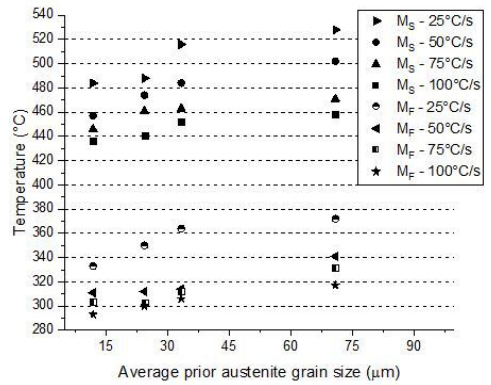
Figure 15. Effect of the austenite grain size upon the martensite start and finish